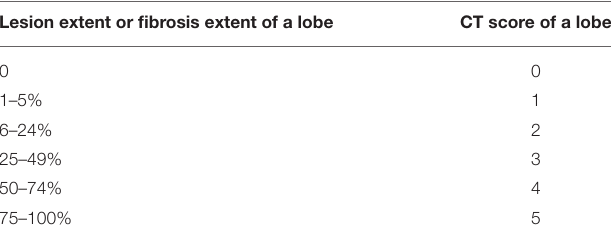
TABLE 1 | CT scoring system of lesion extent on peak CT and fibrosis extent on last follow-up CT. Lesion extent or fibrosis extent of a lobe